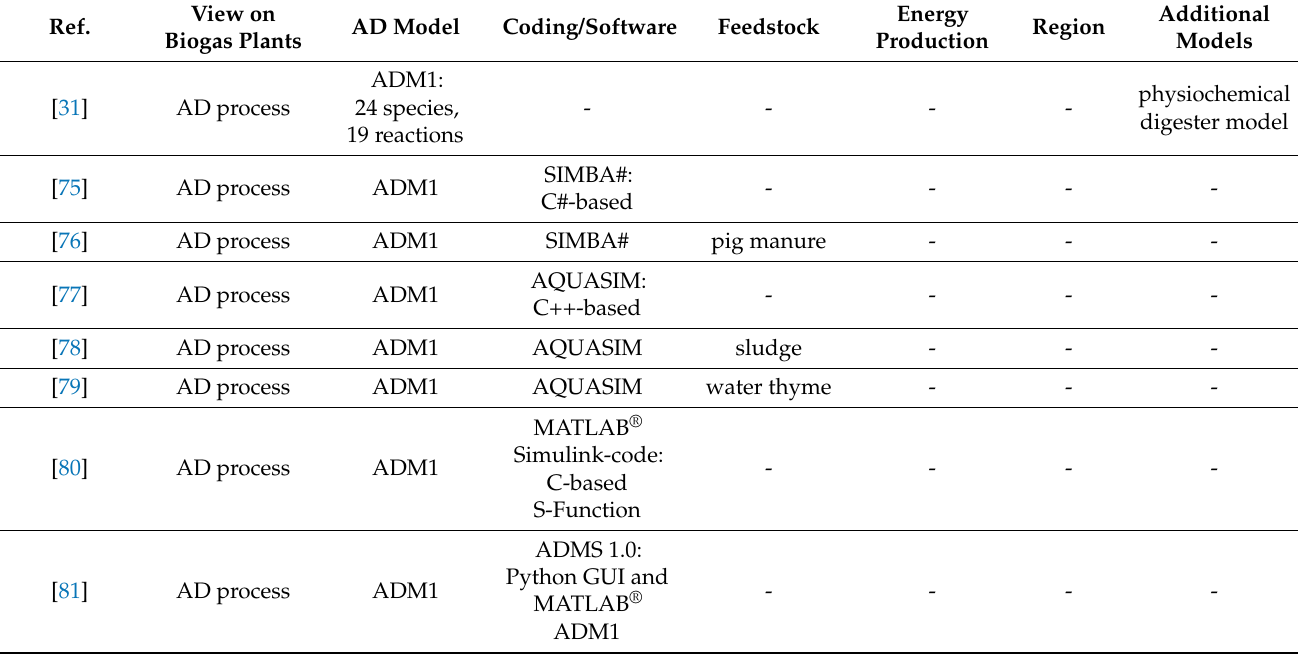
Table 2. Biogas bottom-up modeling (process